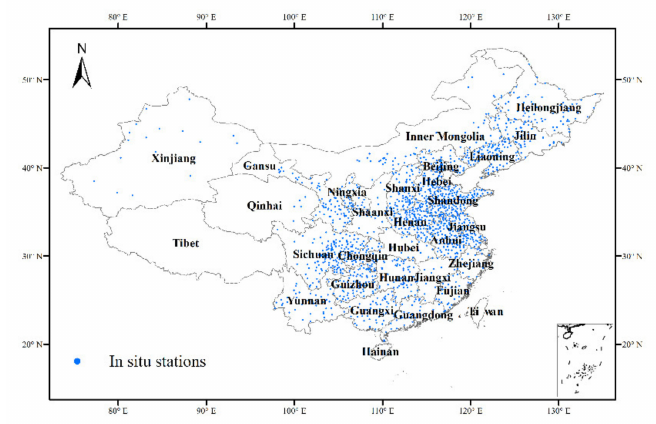
Figure 1. Distribution map of in situ stations (total number of 1682) in China. Labels indicate the respective province